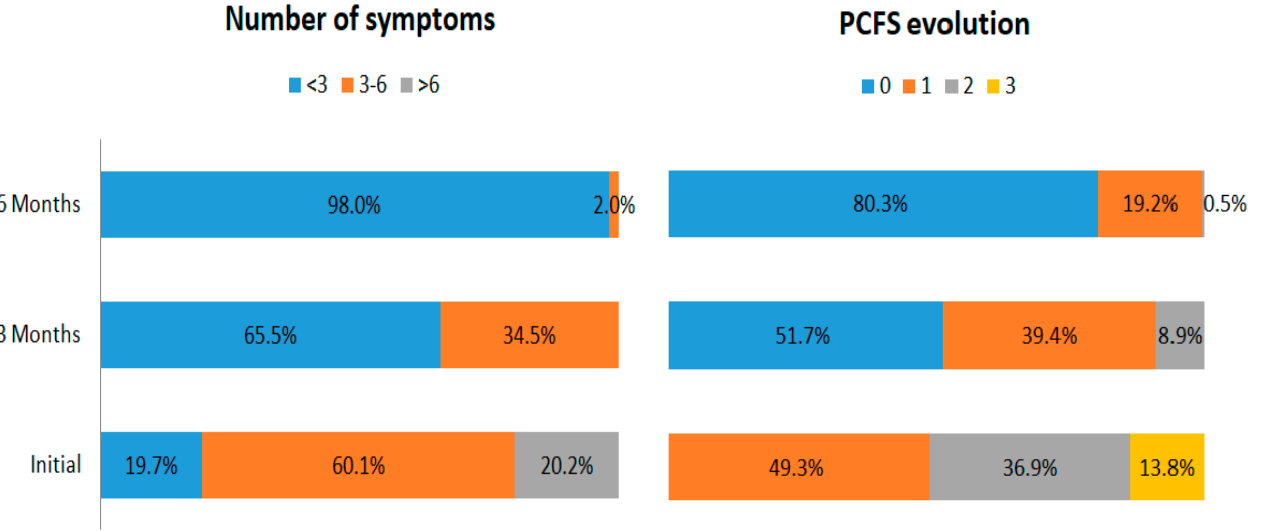
Figure 3. The evolution of symptom numbers and PCFS levels from the initial evaluation to 6 months after COVID-19